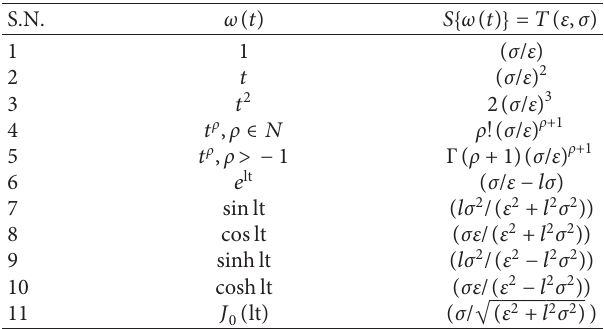
Table 8: Shehu transformation of frequently used functions [12–15]. S.N.